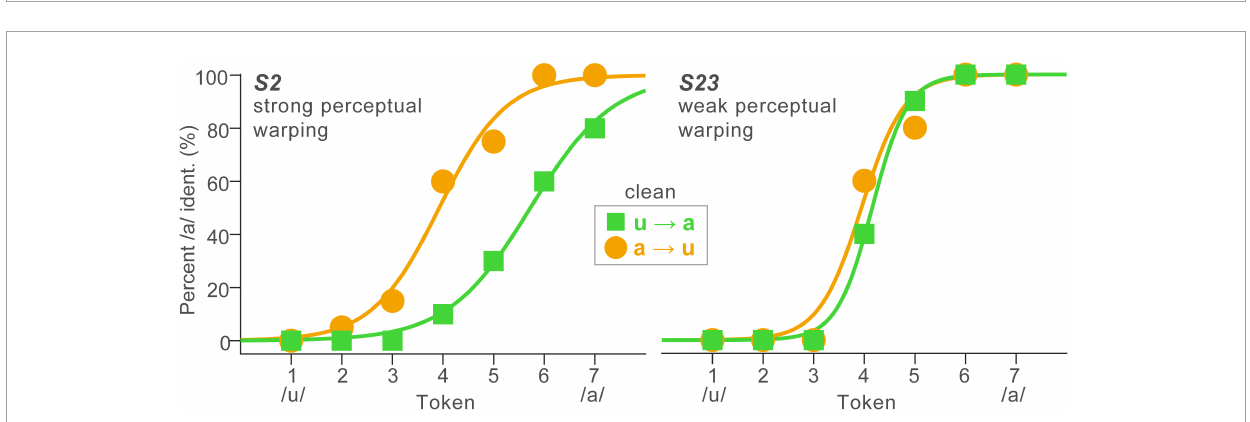
FIGURE2 Perceptual warping in speech categorization is subject to stark individual differences. Identification functions for representative listeners ( n = 2) who showed strong (left) and weak (right) perceptual warping. High influence listeners’ perceptual boundary shifts dramatically with stimulus order context, whereas low influence listeners show little movement in their category boundary with